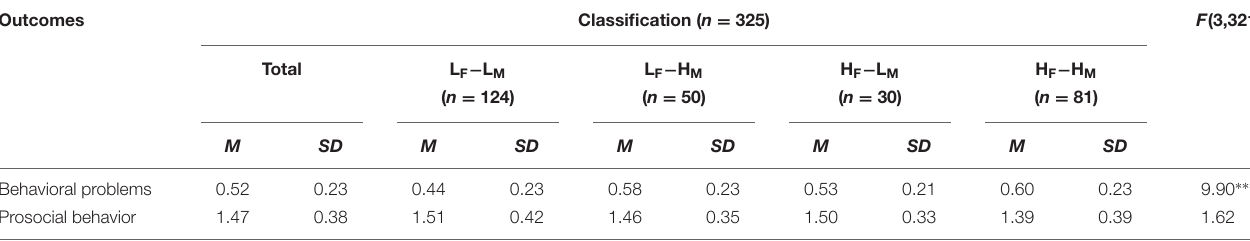
TABLE 3 | Descriptive statistics for children’s socioemotional development. Outcomes